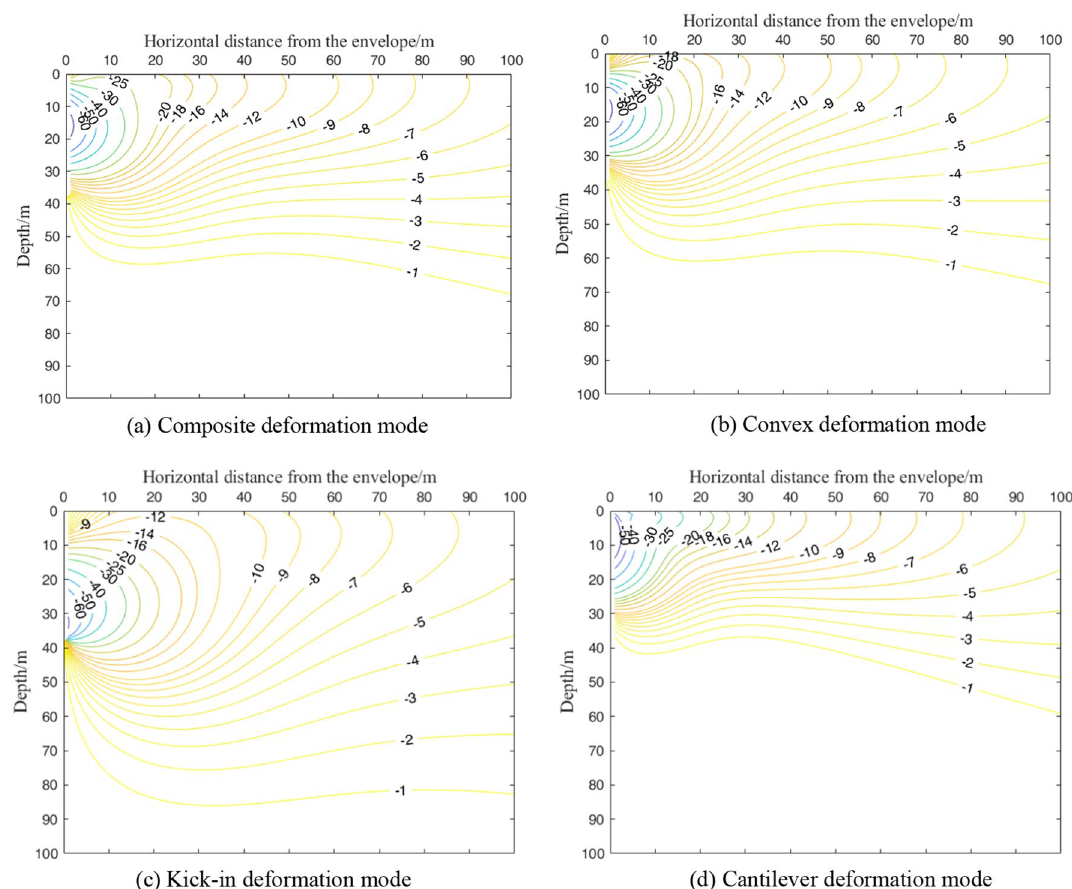
Figure 8. Horizontal displacement field of soil caused by different deformation modes of retaining Figure 8 shows the horizontal displacement field of the soil generated by the four deformation modes of the foundation pit envelope. In Fig. 8, the corresponding soil deformation is marked by color, the negative sign indicates that the soil moves into the foundation pit, and the unit is mm. As shown in Fig. 8a and b, the soil horizontal displacement field generated by the convex deformation mode and the composite deformation mode is similar, and the soil horizontal displacement decreases with increasing distance from the enclosure structure. When the distance to the enclosure structure is relatively short (less than 10 m), the horizontal displacement curve of the soil exhibits an obvious "bow shape". In addition, the horizontal displacement of the surface increases with increasing distance from the enclosure structure, while the horizontal displacement of the deep layer shows a decreasing law. With a further increase in the horizontal distance from